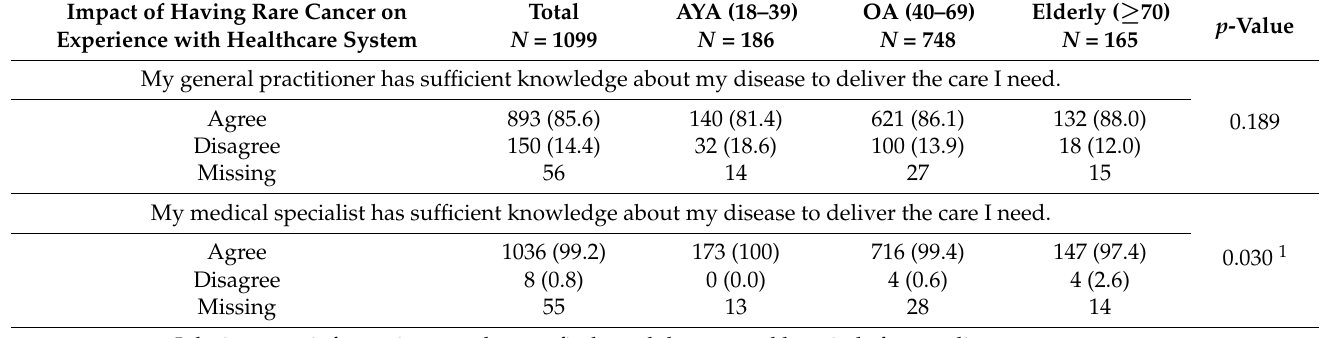
Table 2. The impact of having a rare cancer on the experience with the healthcare system. Impact of Having Rare Cancer on Experience with Healthcare